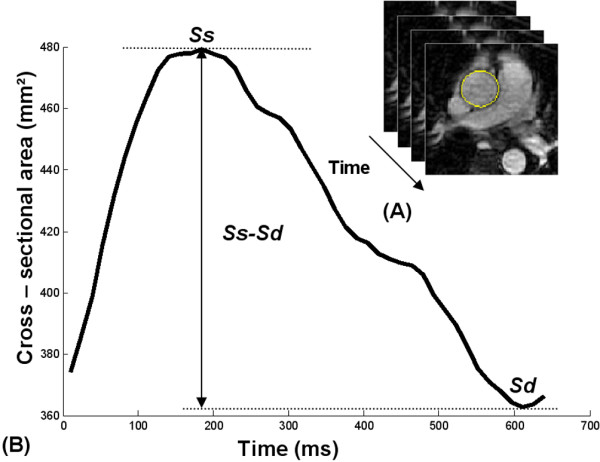
Determination of the aortic cross-sectional area during a cardiac cycle. (A): automatic contouring of the ascending aorta. (B): ascending aorta cross-sectional area versus time curve; Ss and Sd correspond to the ascending aorta systolic and diastolic areas, respectively.